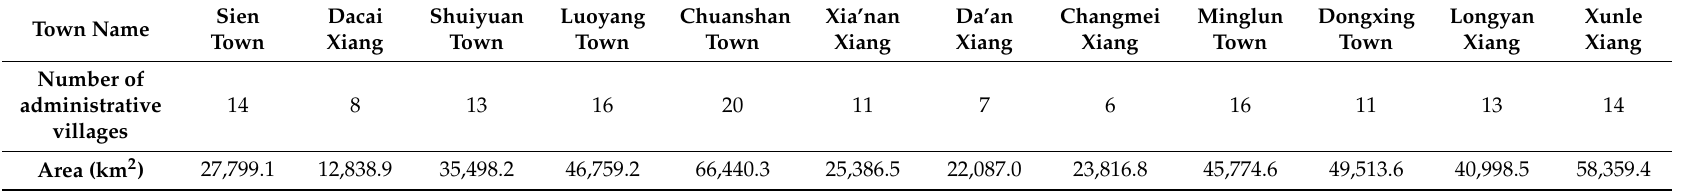
Table 1. Area and number of administrative villages in Huanjiang County townships in